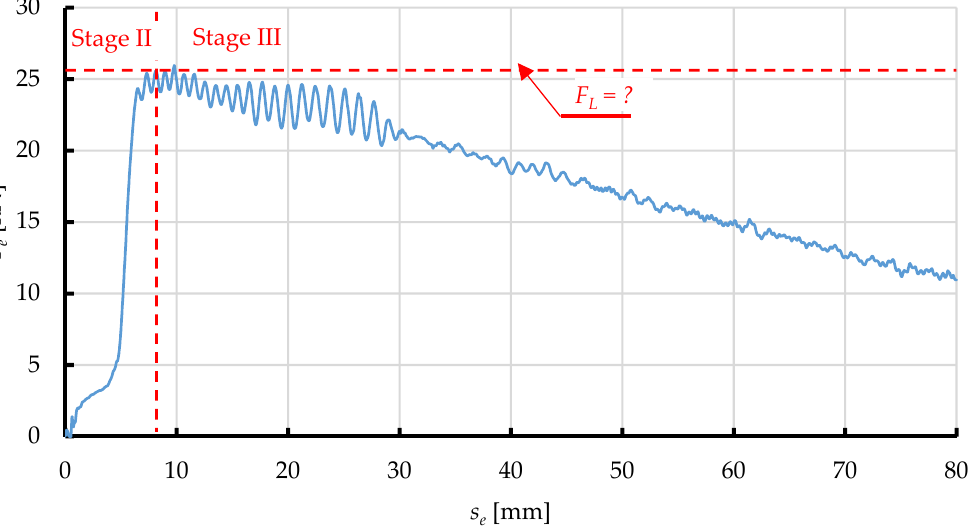
Figure 13. An example of the F e vs. s e relationship during extrusion of dry ice snow through a conical-cylindrical die (CS10), with marked division into phases.